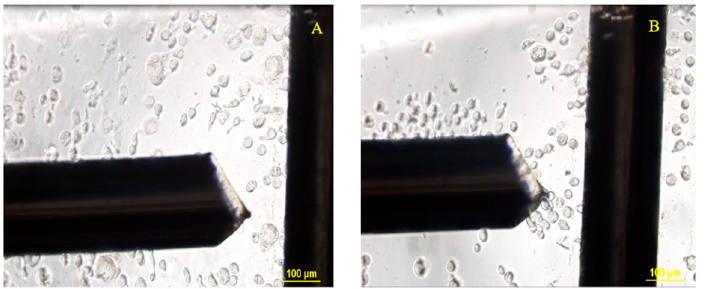
Figure 5. Images showing movement of cells away from and toward the high electric field region, i.e., nDEP and pDEP for 7-day cell groups. ( A ) Treated cells appear to be elongated compared to ( B ) untreated cells. Notably, the degree of elongation varied even though the experiments were at the same timepoint.